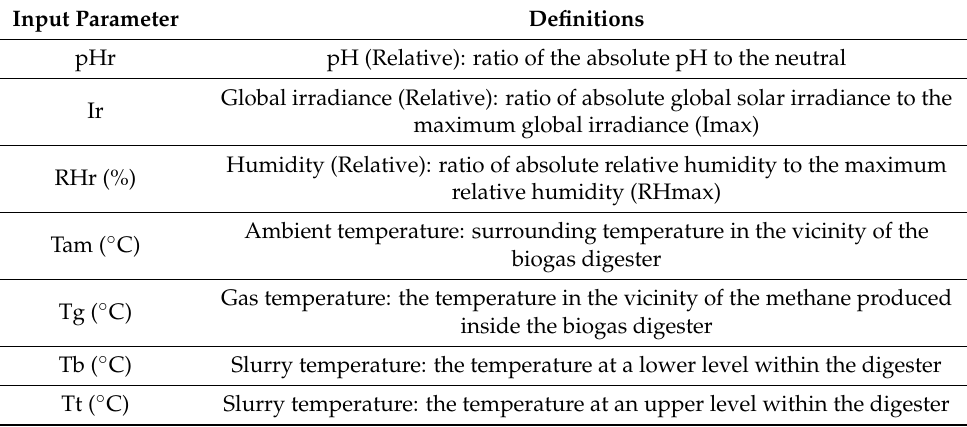
Table 2. Factors used and considered in the study